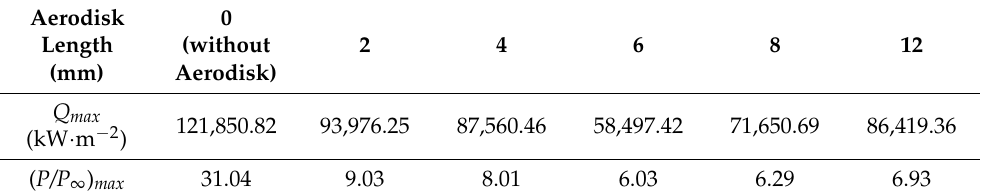
Table 3. Comparison of ( P/P ∞ ) max and Q max with different aerodisk lengths.